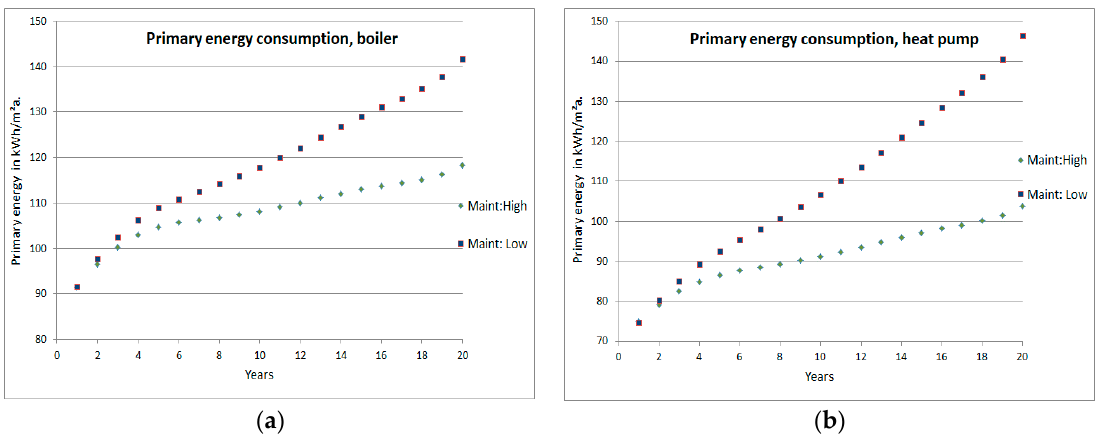
Figure 4. Combined impact of XPS and ( a ) boiler; ( b ) heat pump degradation on building primary energy consumption.